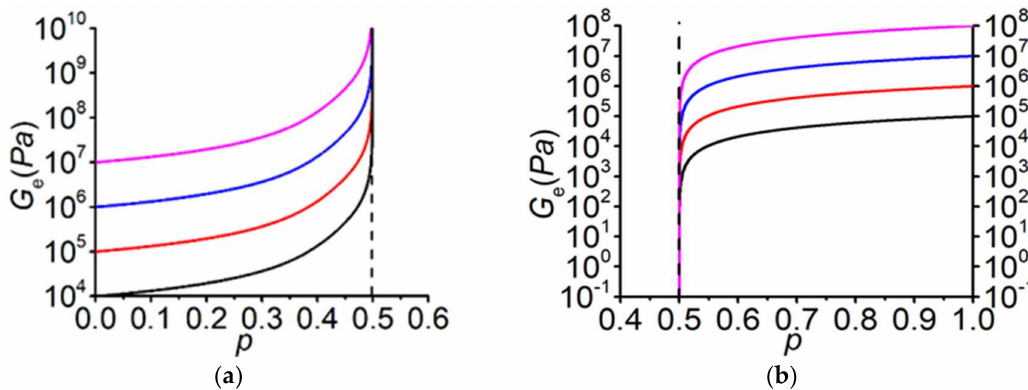
= 0. ( a ) Di ff erent shear G 1